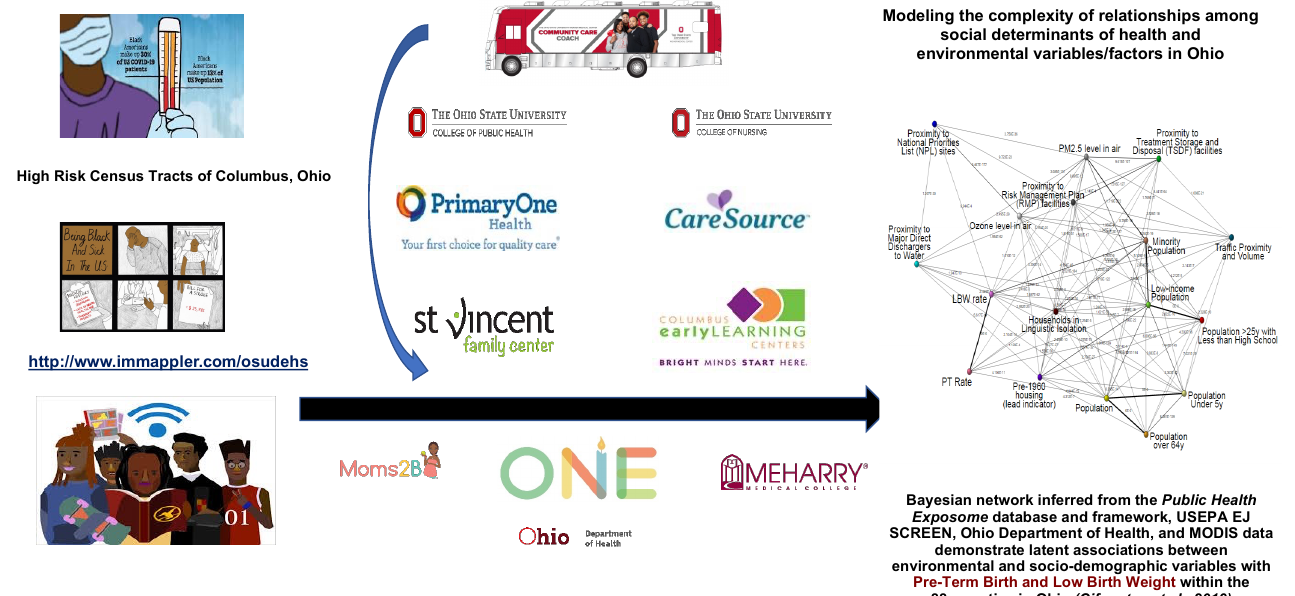
GLOBAL SIGNIFICANCE, LOCAL IMPACT Figure 1. Graphic depiction of our transformative community engagement model that is referred to as E 6 , Enriching Environmental Endeavors via e-Equity, Education and Empowerment. This model utilizes a functional, multidisciplinary, community-based research stakeholder team to educate and improve the quality of life for residents living in environmental justice communities, as well as to foster citizen science among residents and researchers. The E 6 model prioritizes the perspectives and desires of the residents and is a novel approach to bring effective mitigation strategies directly to where residents live, work, play, and pray (See text for details). [Reproduced and adapted with permission from the corresponding author of Cifuentes et al., 2019 on 18 October 2022]